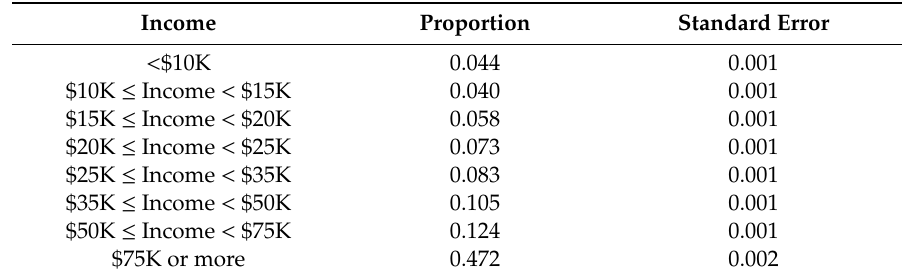
Table 1. Variable INCOME2: “Is your annual household income from all sources: (If respondent refuses at any income level, code “Refused”) [20]”.